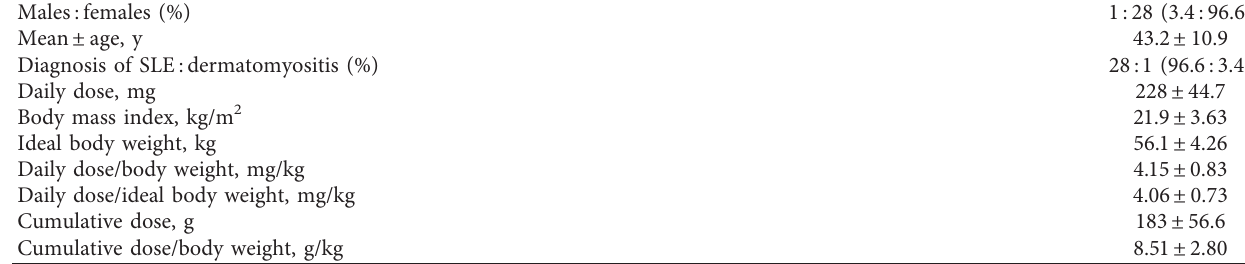
Table 1: Demographic data and clinical characteristics of the patients.